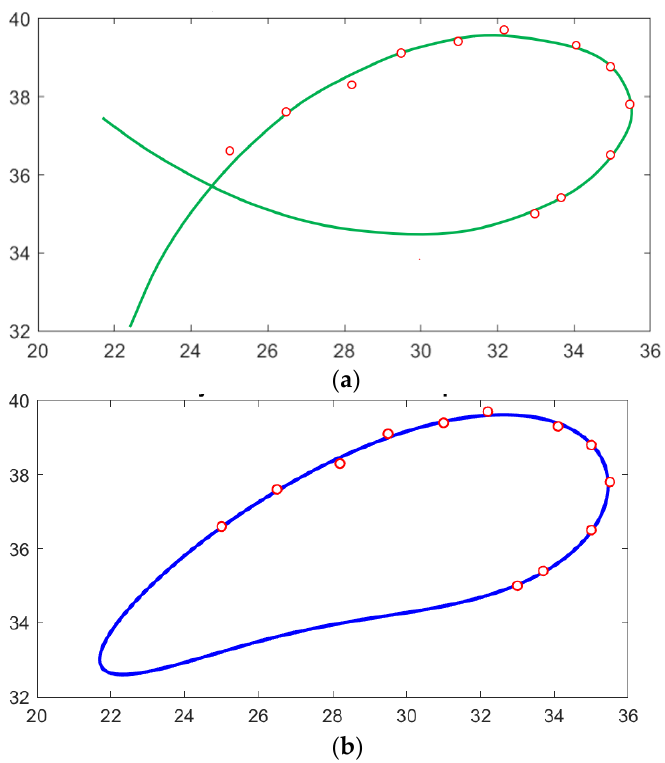
Figure 11. ( a ) Watt’s mechanism optimal solution from [41]; ( b ) optimal solution for slider-crank mechanism. Table 4. Example 3: Optimum design parameters and